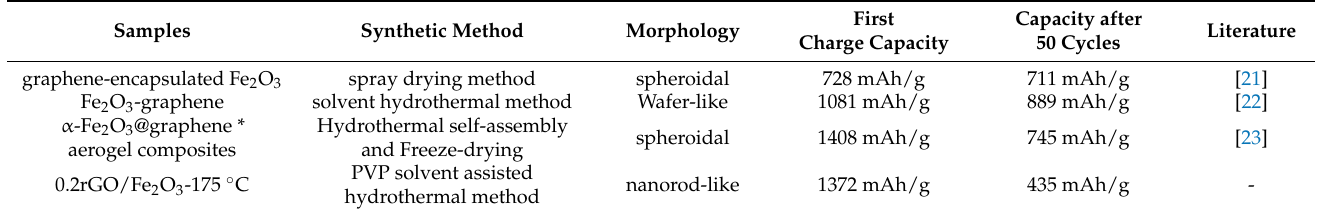
Table 1. Comparison of synthesis methods, morphology and electrochemical properties of different iron oxide and graphene